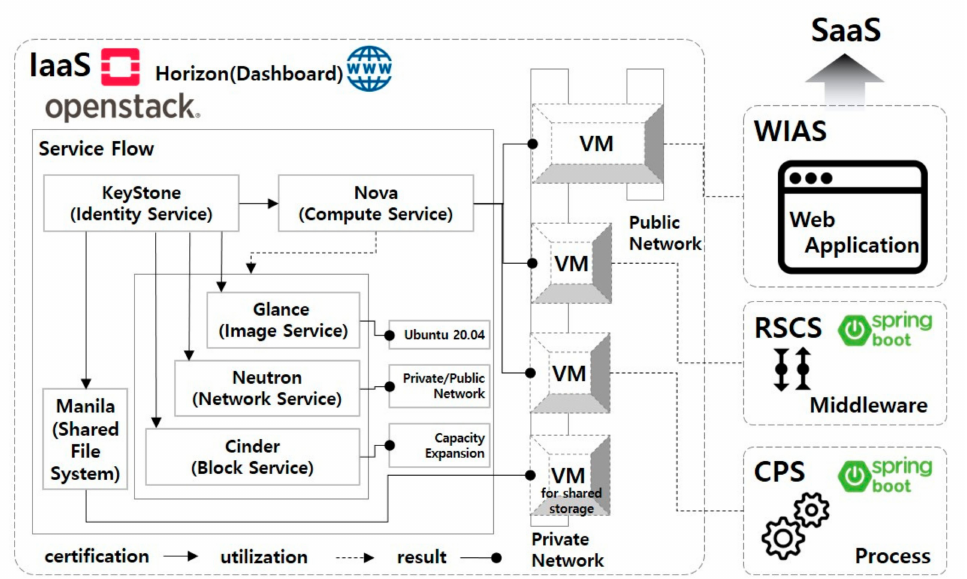
Figure 2. Linkage of OpenStack-based IaaS and